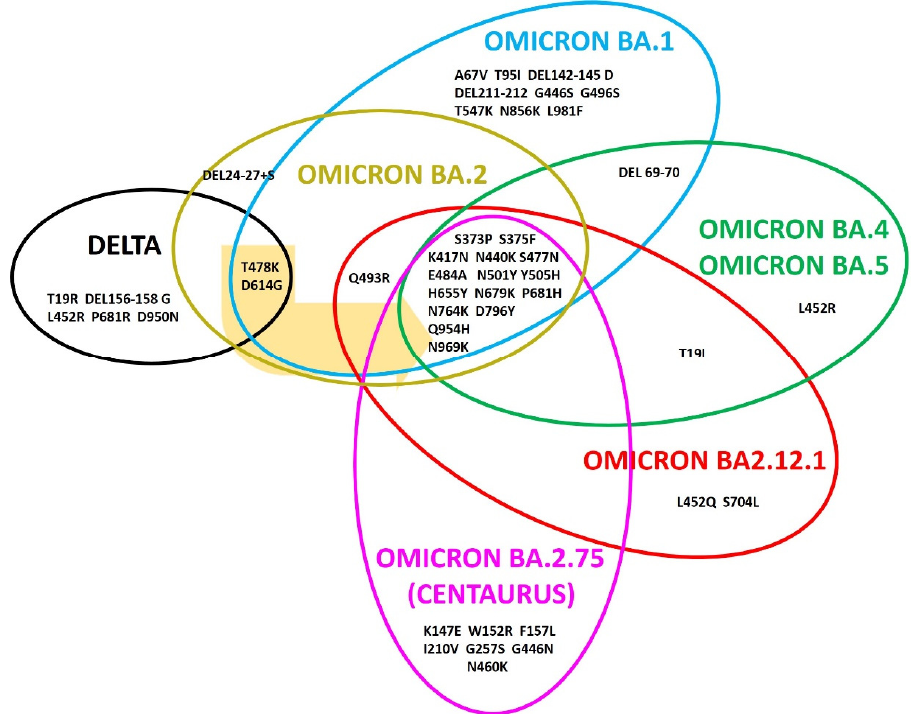
Figure 1. Schematic representation of the omicron variants evolution starting from delta. The common mutations are reported at the overlap among the variants. The mutations present in all the omicron variants are S373P, K417N, N440K, S477N, T478K, E484A, N501Y, Y505H, D614G, H655Y, N679K, P681H, N764K, D796Y, Q954H and N969K, and T478K and D614G derived from delta, indicated by the yellow arrow. The unique mutations of each variant are reported outside the overlap among the variants.